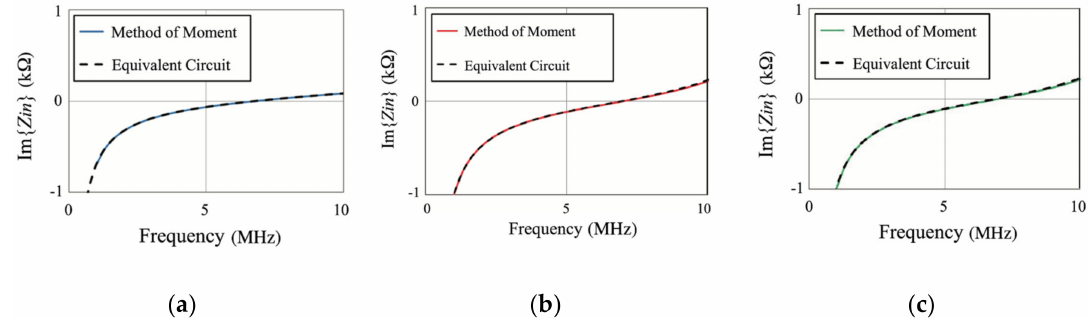
Figure 3. Input impedances calculated by Method-of-Moment (MoM) and equivalent circuit.